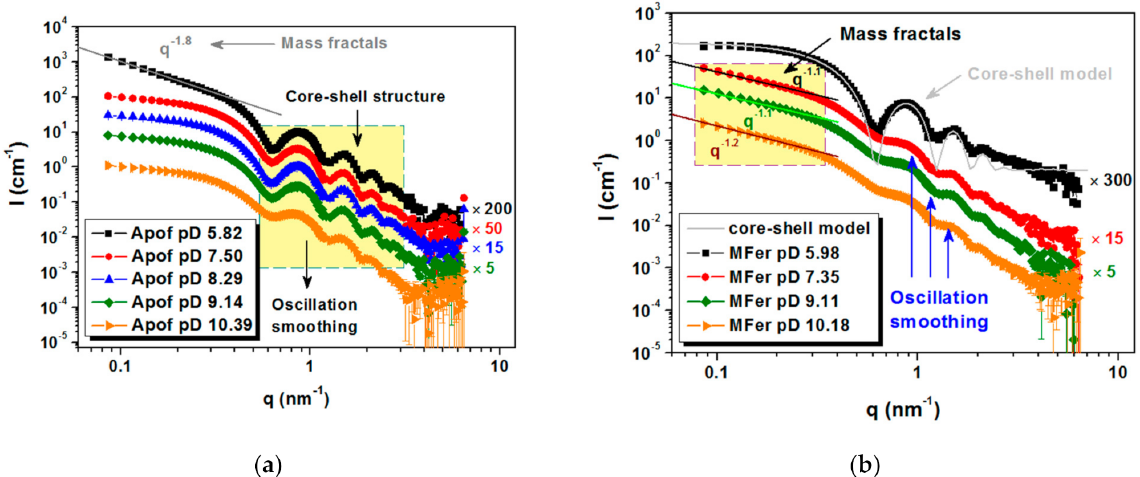
Figure 6. Scattering curves for protein colloidal solutions for: ( a ) apoferritin at full contrast at five different solution pD (10.39; 9.14; 8.29; 7.50 and 5.82) and ( b ) MFer LF 190 at full contrast at five different solution pD (10.18; 9.11; 7.35; and